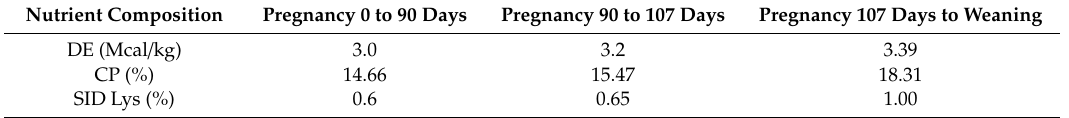
Table 1. Feeding standards during pregnancy and